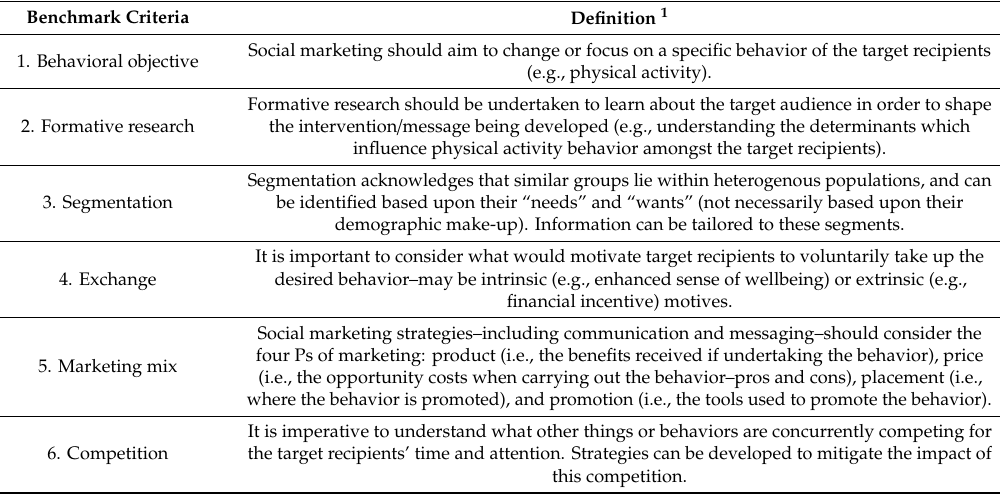
Table 3. Andreasen’s Social Marketing Benchmark